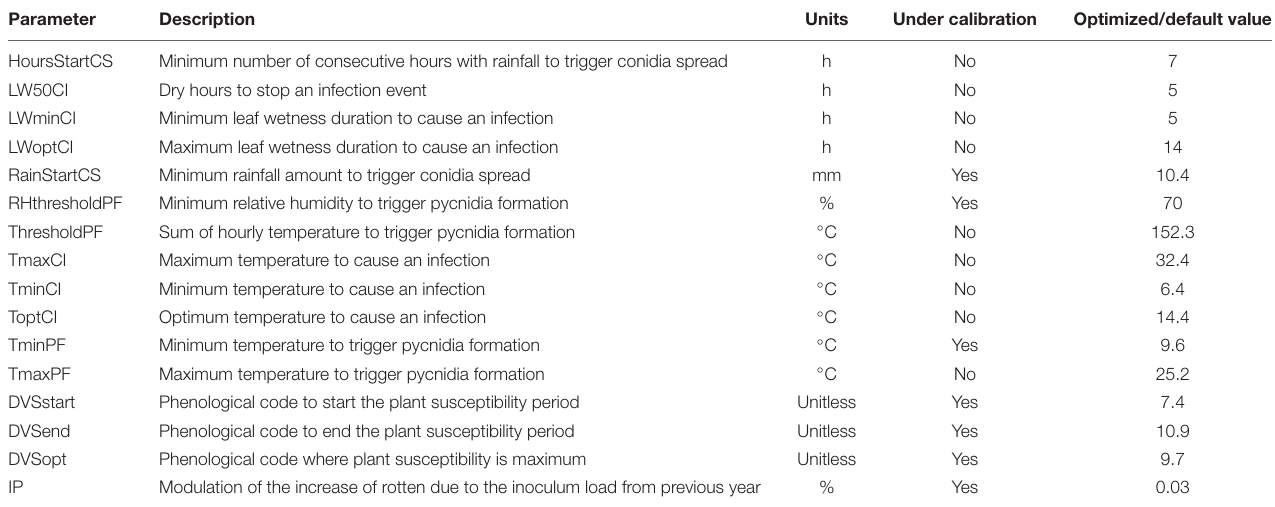
TABLE 2 | Acronym, units, and description of the parameters of the model of rotten